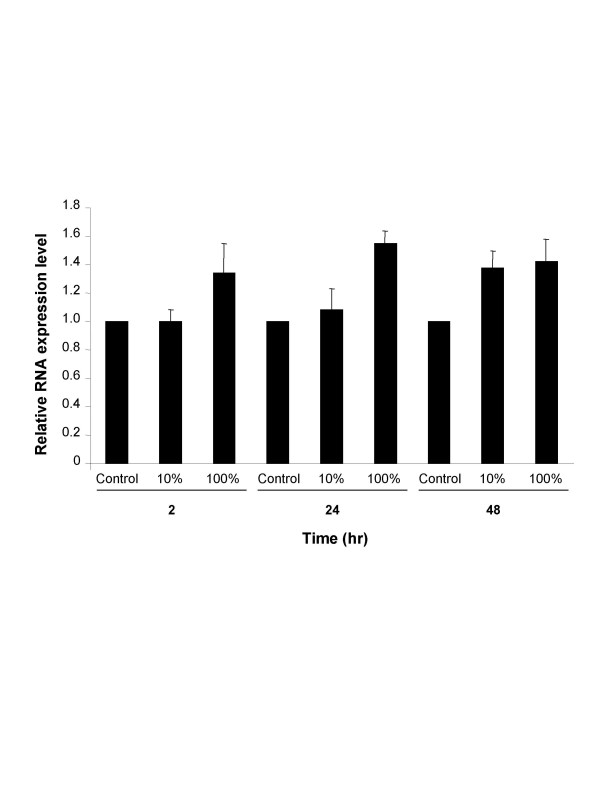
Mean RNA expression levels for pirin assessed by quantitative PCR in human bronchial epithelial (HBE) cells exposed to varying concentrations of cigarette smoke extract (CSE) over time. RNA was extracted from HBE cells after exposure to 10% and 100% CSE and pirin RNA levels were quantified relative to the control gene GAPDH by real-time quantitative PCR by TaqMan. Each data point was generated from triplicate wells; and a total of three separate data points were obtained for each condition at each time point. The ordinate represents the fold change in pirin expression in samples exposed to 10% and 100% CSE over time relative to the background pirin expression level in cells cultured in the absence of CSE.